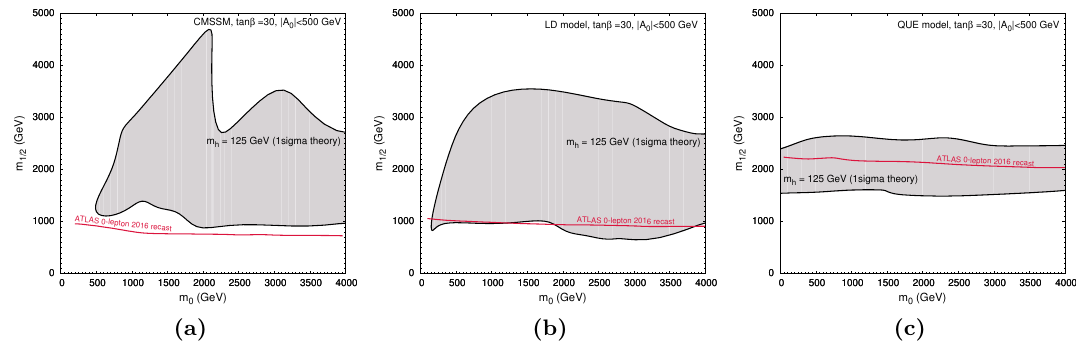
Figure 2. The red solid line marks the ATLAS 0-lepton search lower bound [5]. The region of correct Higgs mass in the ( m 0 , m 1 = 2 ) plane for tan (cid:12) gray shaded in: (a) CMSSM, (b) the LD model and (c) the QUE